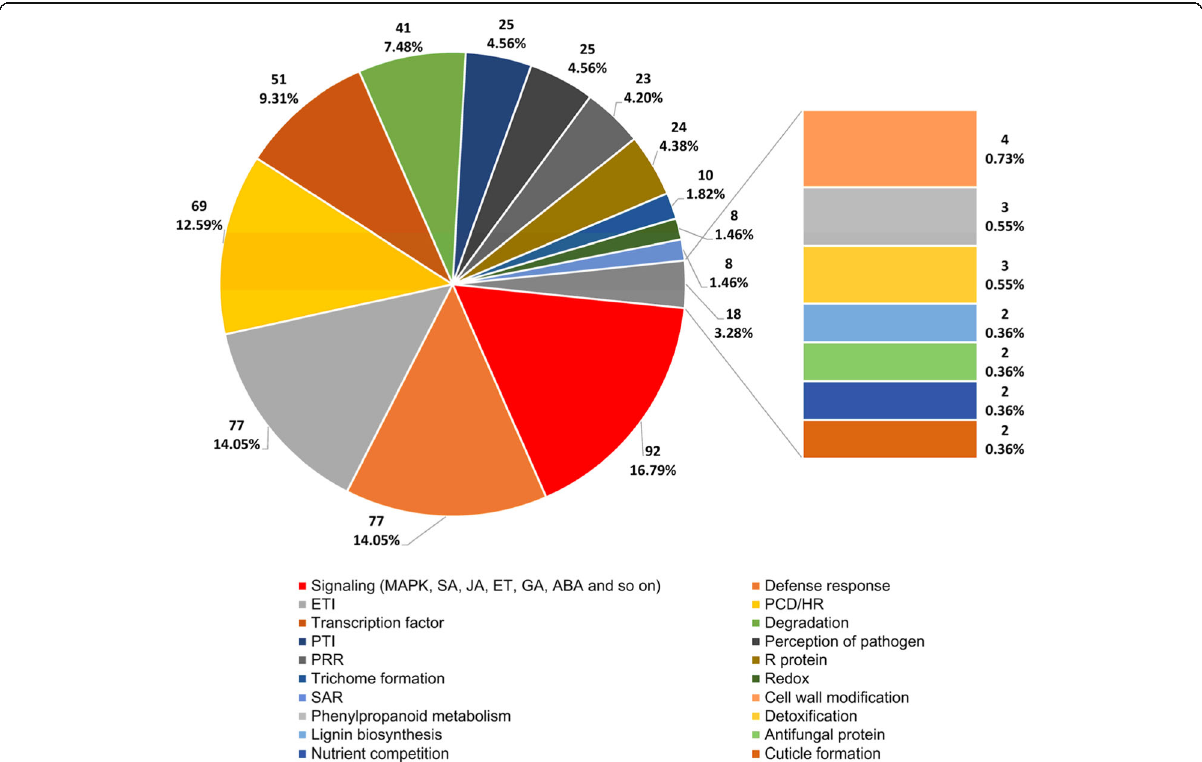
Fig. 3 Analysis on disease resistance mechanisms of the identified DRR/DSR proteins encoded by the rice genes under the control of PIPs